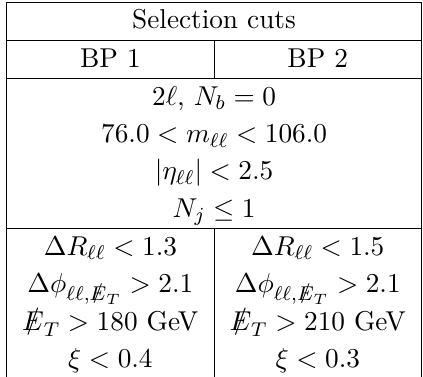
Table 4. The optimised selection cuts for the cut-based analysis in the b-veto category of ‘‘ + /E channel. T